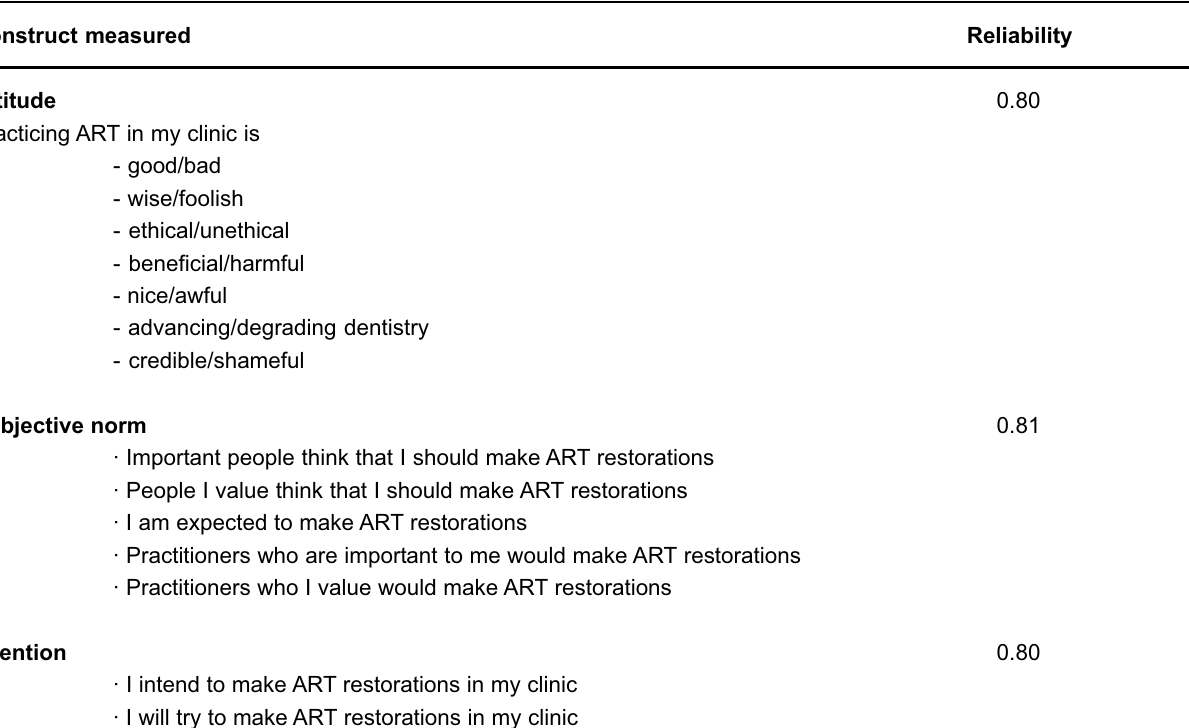
TABLE 2- Items used to measure attitude, subjective norm and intention to practice ART and their reliability coefficient (Cronbach’s α